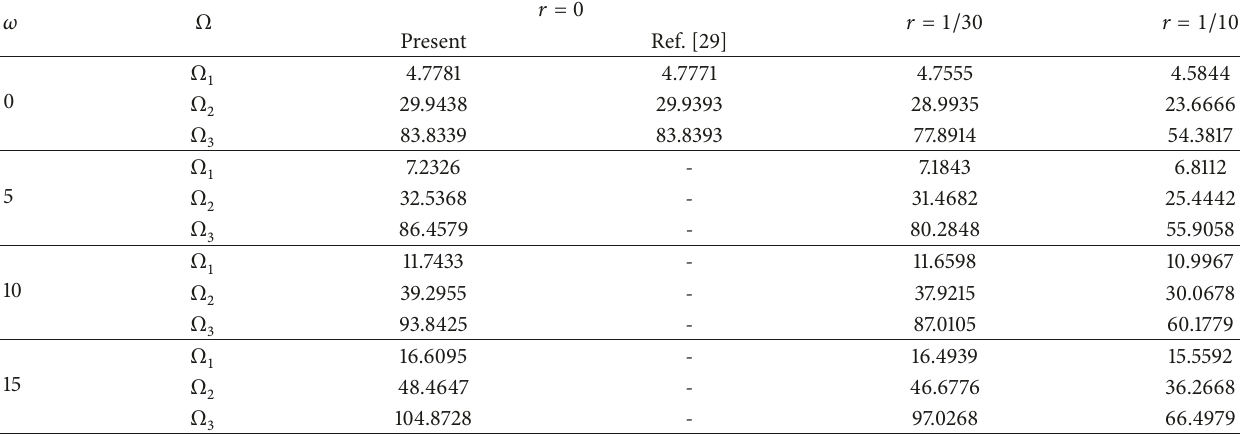
Table 4: The first three order dimensionless natural frequencies of rotating circular thin-wall cross-section beams at 𝑟 0 = 0 , 𝛽 = 0.92 , 𝜆 = 1 . 𝜔 Ω